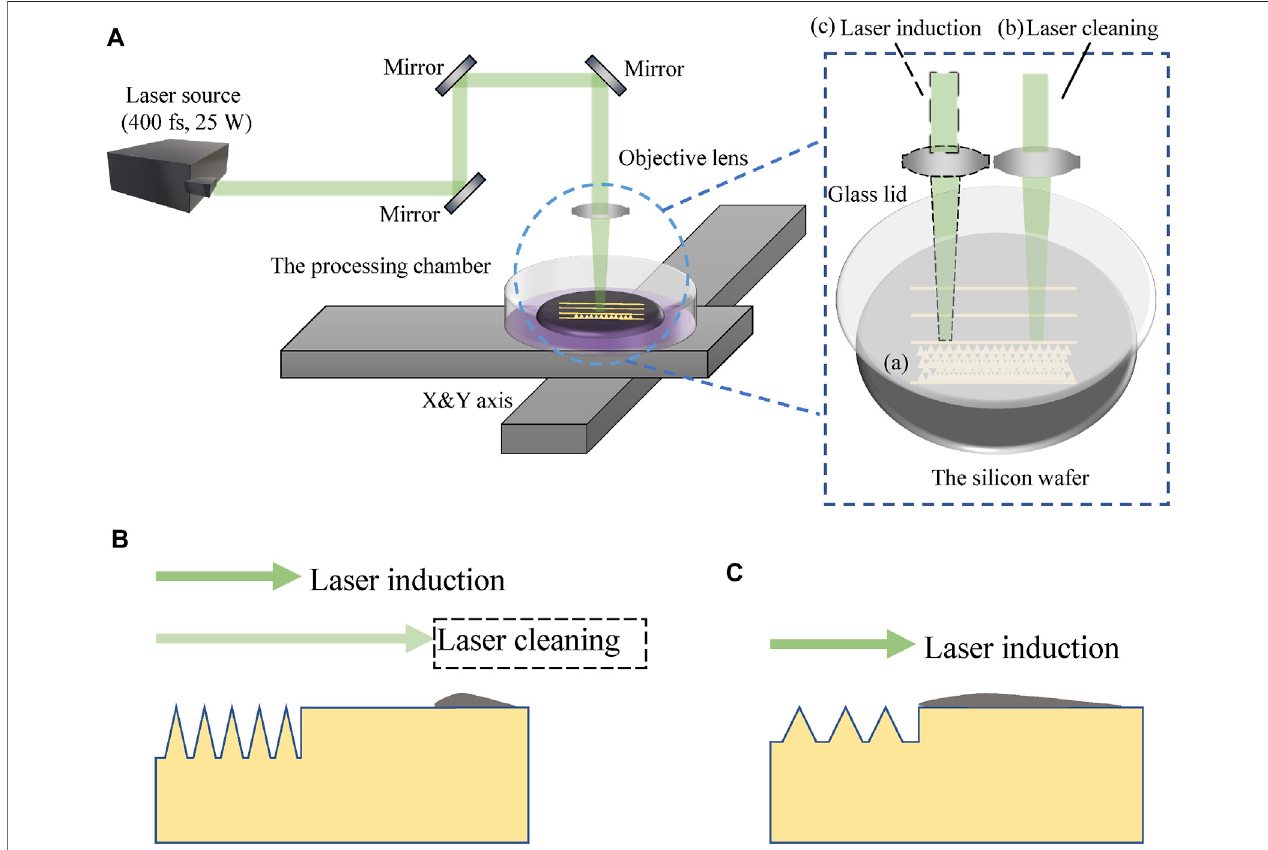
FIGURE 1 | (A) Schematic diagram of the femtosecond laser processing system. (B) Laser induction assisted with laser cleaning and (C) conventional laser induction.